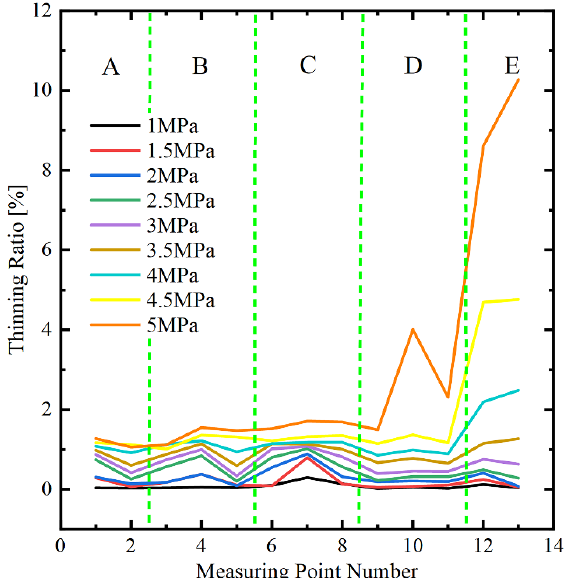
Figure 6. Thicknesses thinning ratio of toroidal pressure hulls after spring back subjected to various hydroforming pressures.